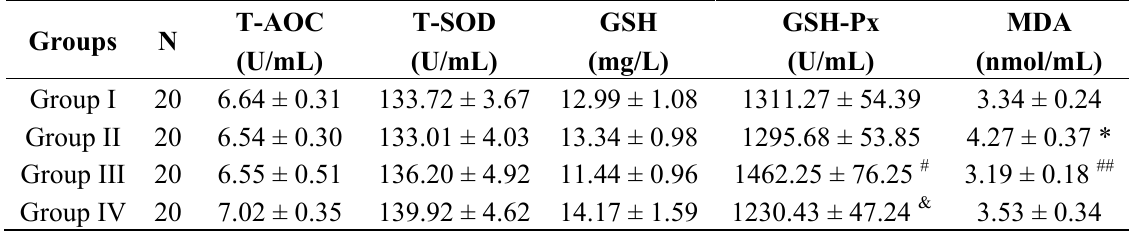
Table 3. Oxidative stress markers in blood of rats (X  SEM).